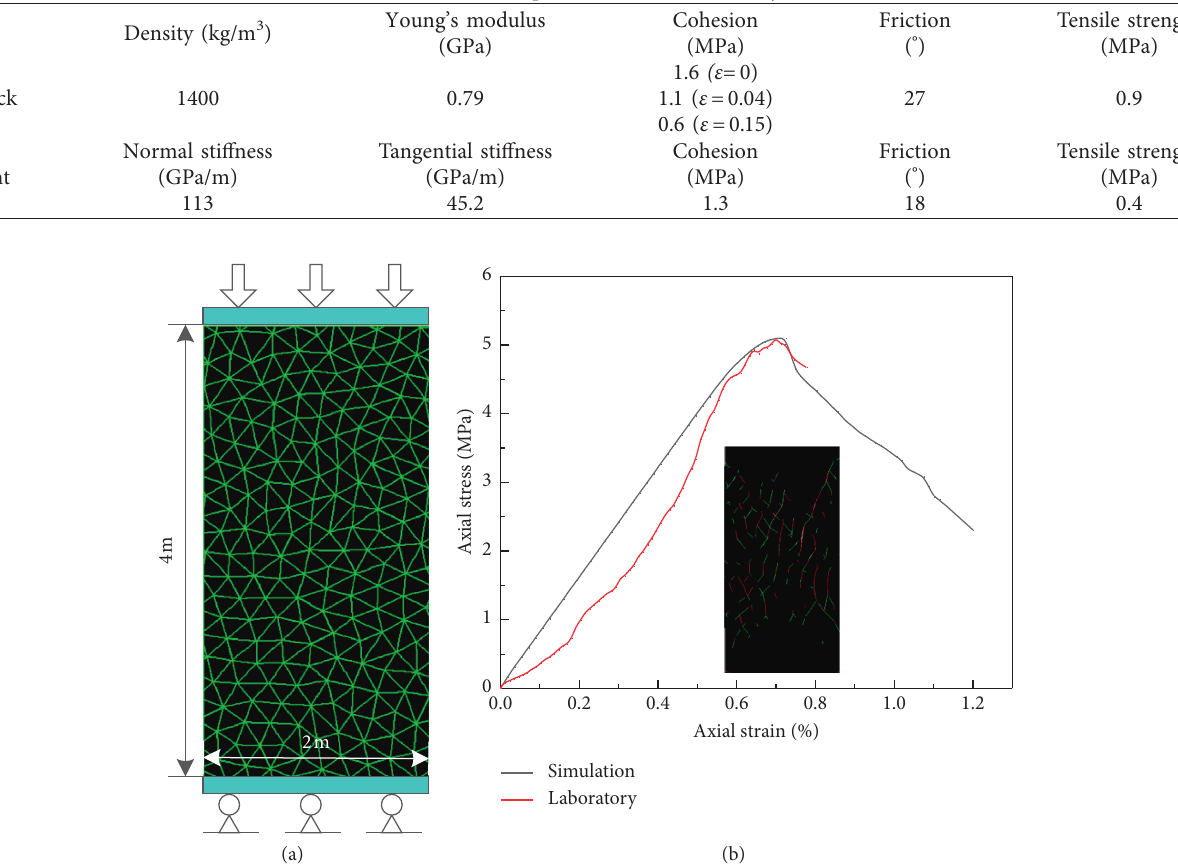
Figure 1: Results of UCS testing: (a) numerical simulation of uniaxial compression and (b) stress-strain curve of coal.